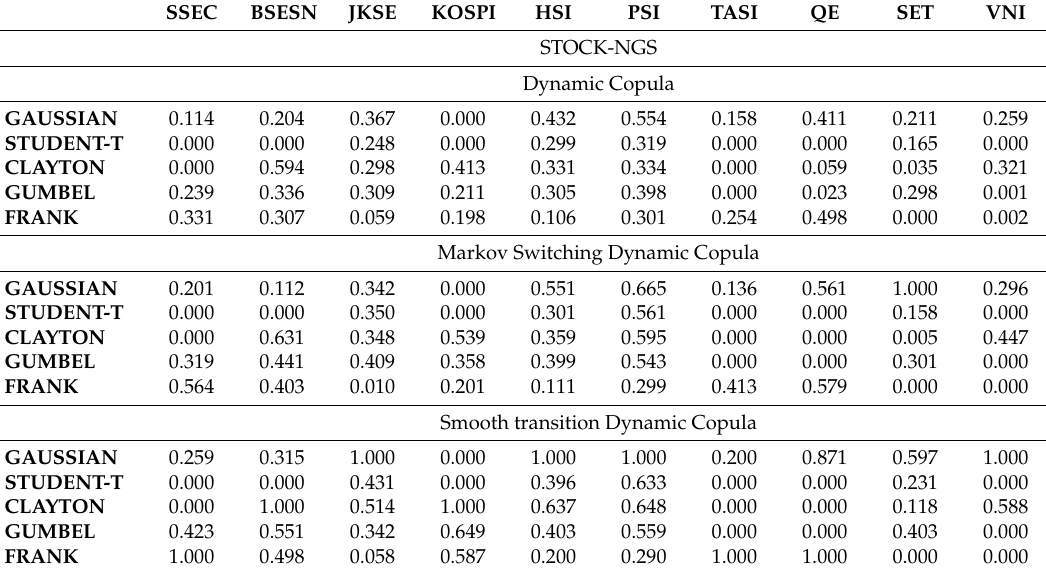
Table 13. The out-of-sample evaluation of forecasts of correlation between negative gold shock and stock